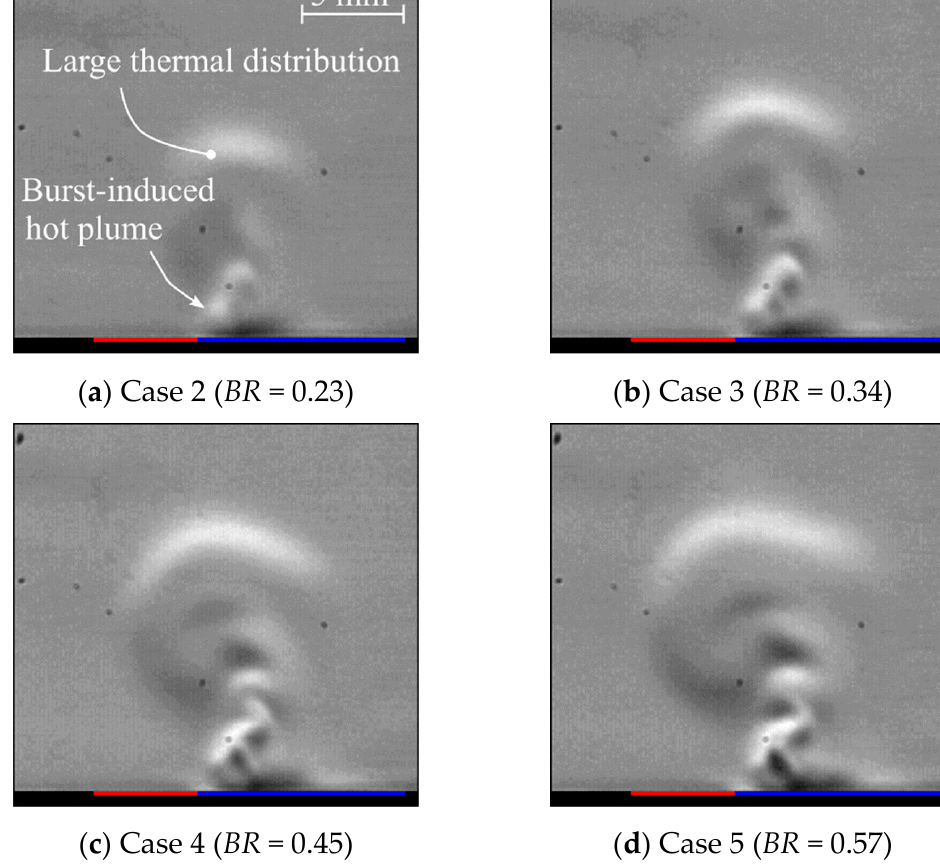
Figure 8. The thermal perturbation at the elapsed time of ∆ t = 50 ms (nine burst events) in the burst plasma discharge